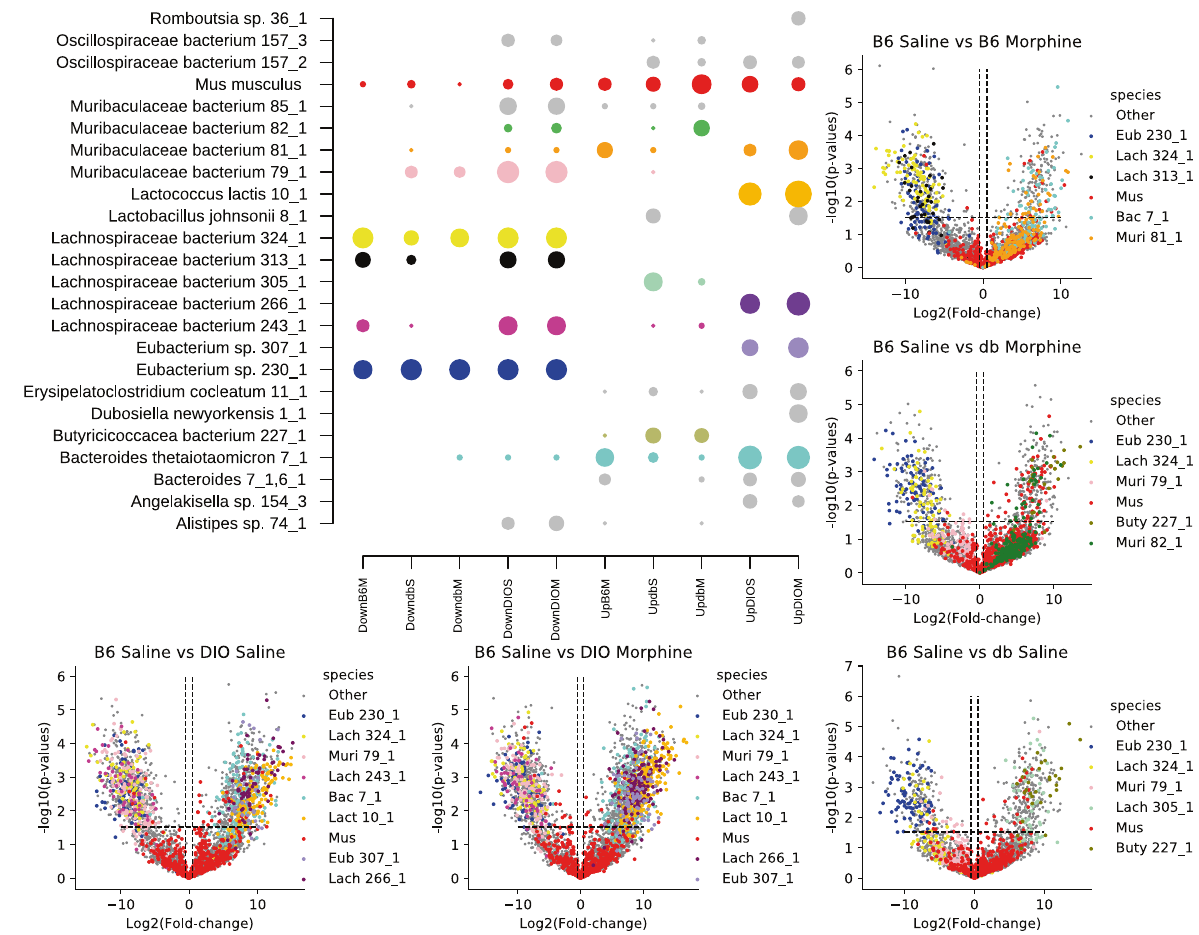
Fig. 3 Differential protein abundance analysis reveals speci fi c Lachnospiraceae species that favor B6 saline over B6 morphine and are distinct for different kinds of obesity. Bubble plot of species with at least 15 or more signi fi cant proteins in a comparison between B6 saline and other experimental conditions. Volcano plots of each binary comparison among B6 saline and another experimental condition. Dotted black lines depict a log 2 fold change of 0.5 or greater, and Benjamini-Hochberg procedure Q < 0.1 threshold. P values were calculated by student t test. Colors are species speci fi